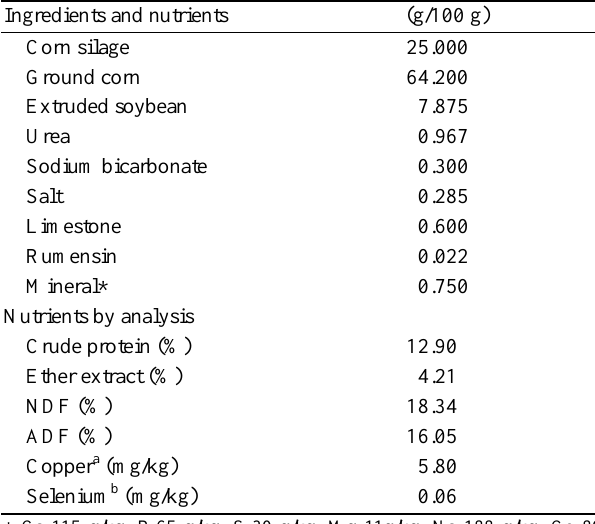
Table 1. Composition of the basal diet (dry matter) Ingredients and